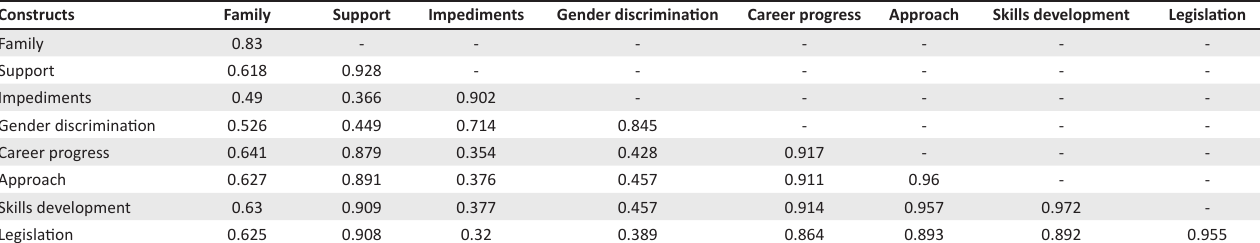
TABLE 3: Correlation matrix to assess discriminant validity.